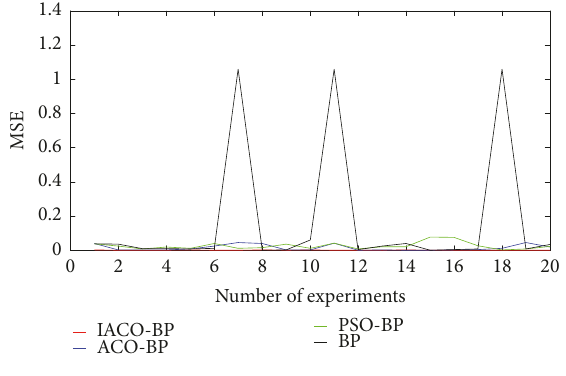
Figure 5: MSE curves of four algorithms.